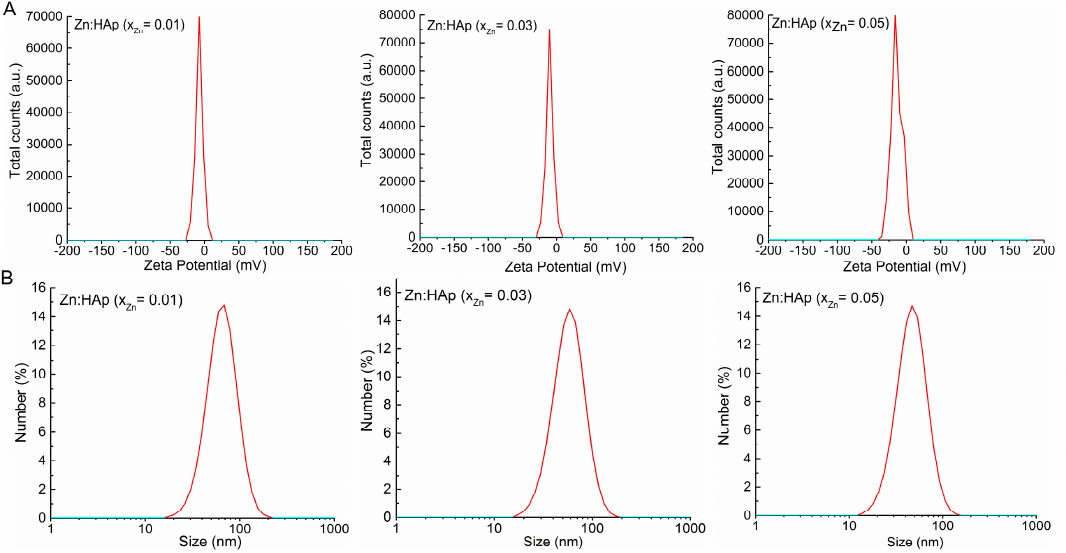
0.01 ≤ x Zn ≤ 0.05 are presented in Figure 5A,B.